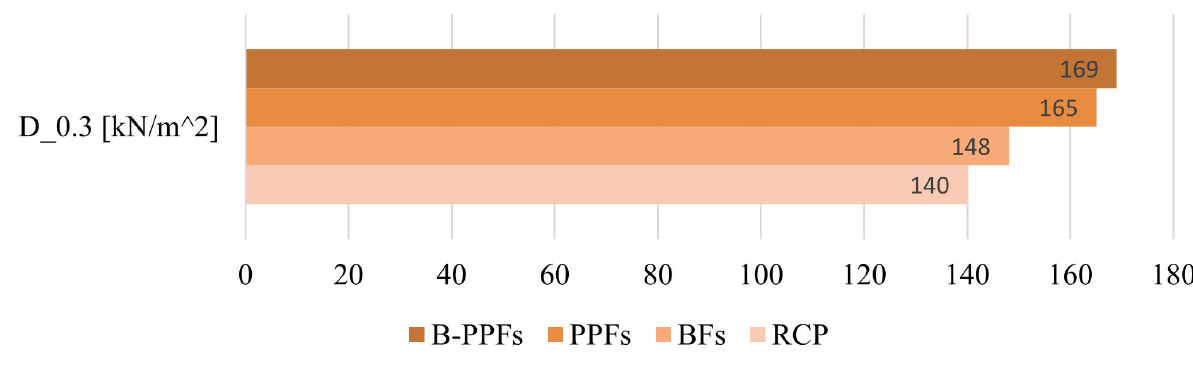
Figure 4: The service load of normalised pipe load-carrying capacity when the crack width is 0.3 mm for different reinforced concrete pipes (Deng et al. 2021a).